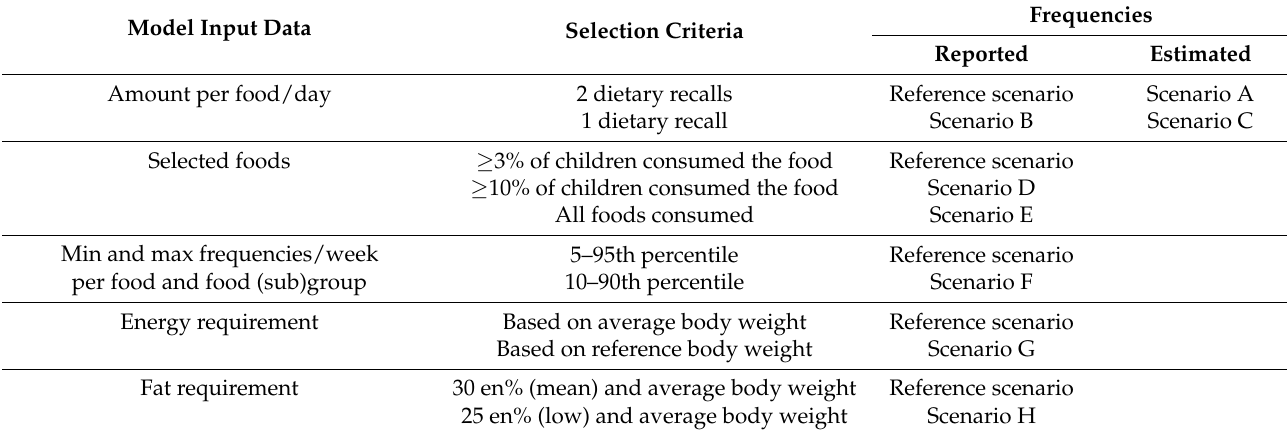
Table 1. Reference scenario and alternative scenarios A-H used to define model input data for linear programming. Model Input